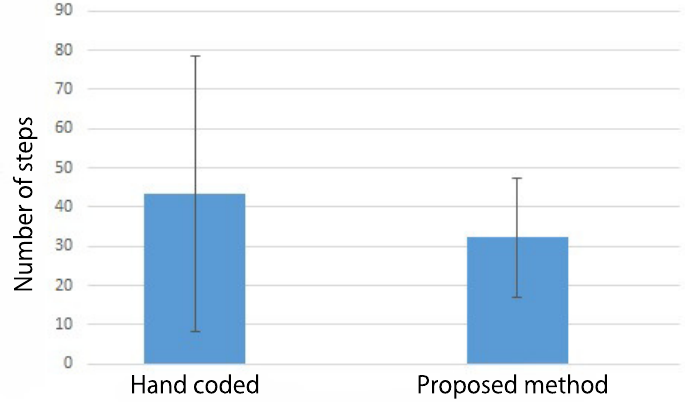
Figure 12. Averaged number of steps and standard deviation over five trials ( n = 5) in Robot 1, for comparison between the proposed and hand-coded methods.